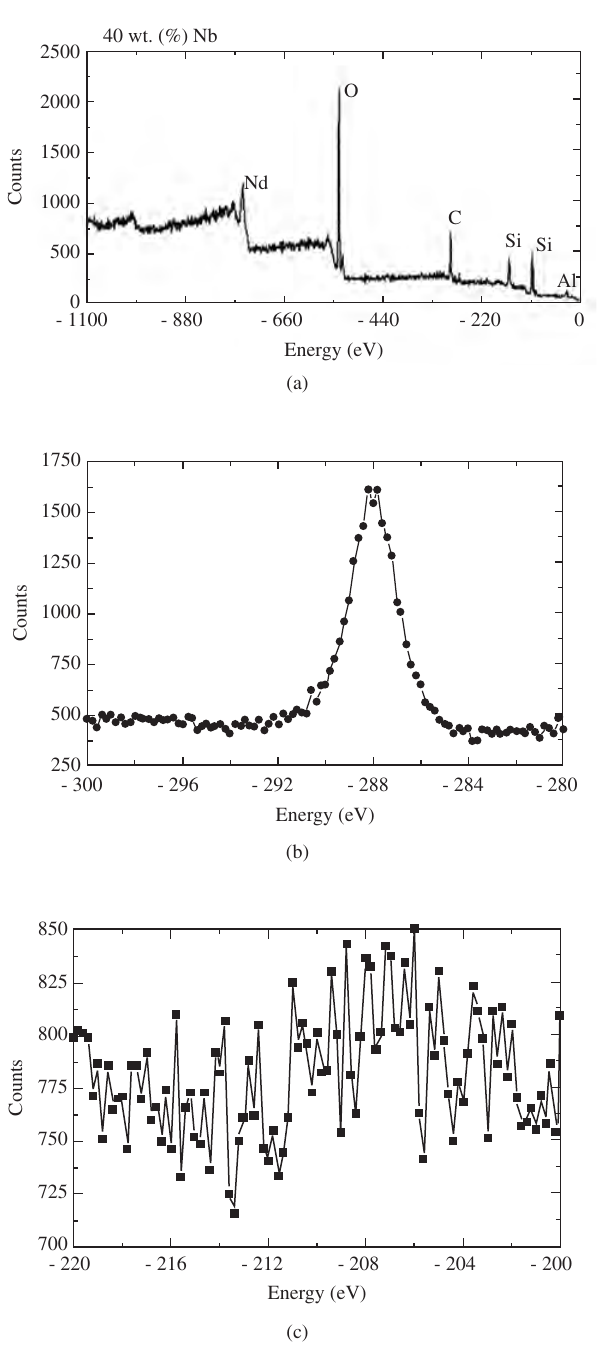
Figure 3. XPS analysis of the sample with 40 wt. (%) Nb, showing the spec- trum of: a) general chemical specimens; b) carbon; and c) niobium.